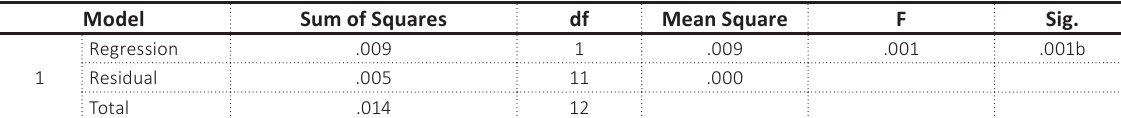
Table 4b. ANOVA result for hypothesis one